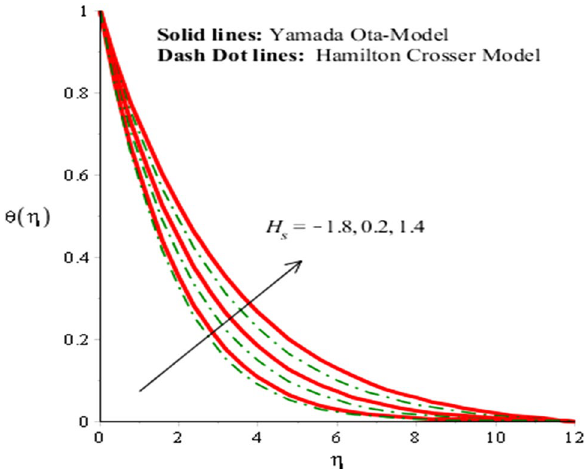
Figure 6. Analysis of heat energy field in against H s when ∅ 1 = 0.002, ∅ 2 = 0.0075, (cid:31) = 0.3, β e = 0.3,